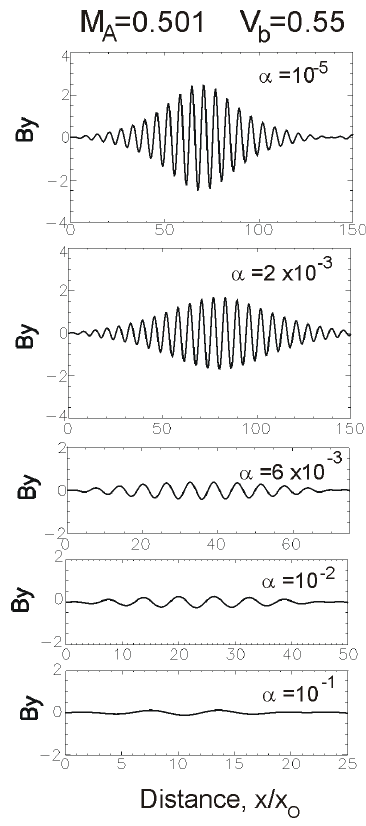
Fig. 15. Amplitude of oscillatory waves in a beam-plasma system at different values of the beam density α = n b /n p ( M Ae = 0 . 501 ,V b = 0 . 55 V Ae